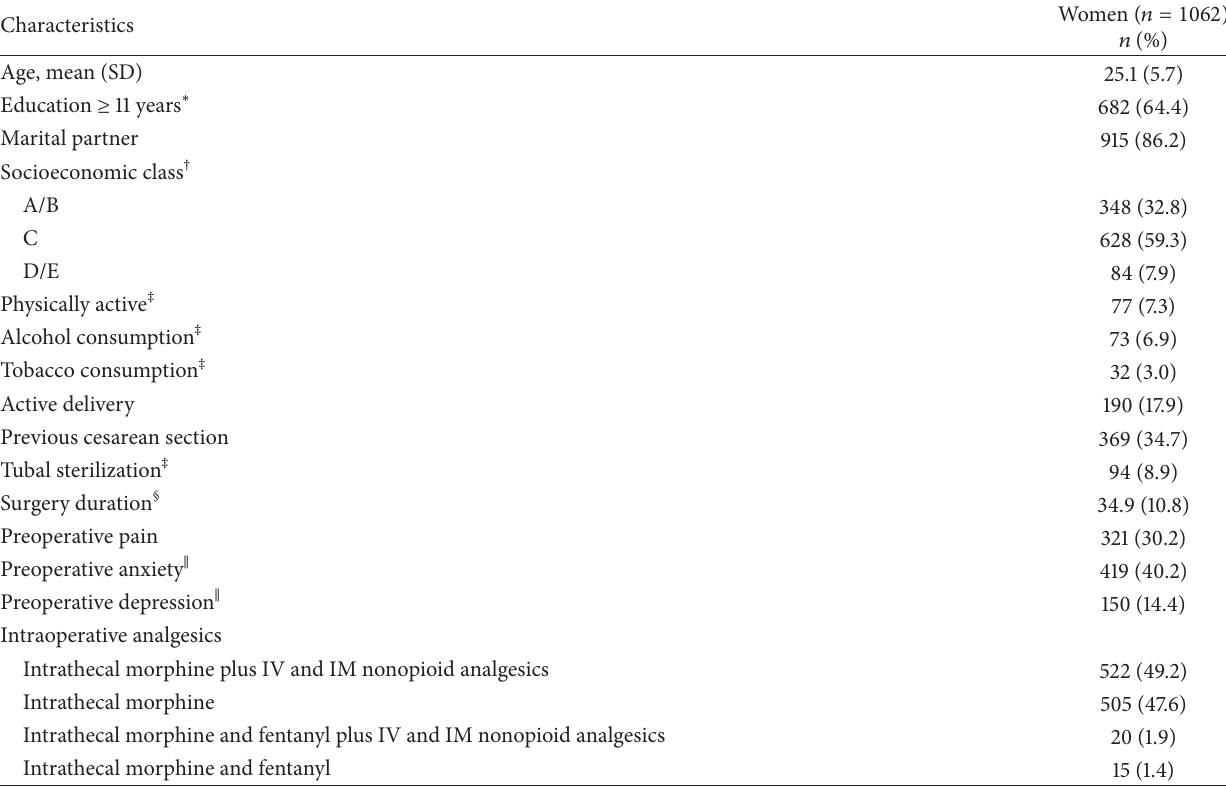
Table 1: Demographics and baselines characteristics.